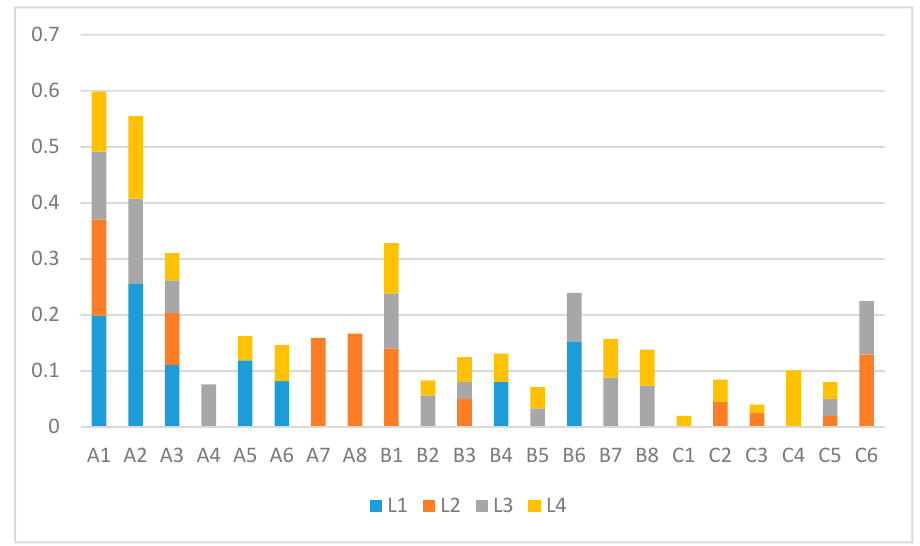
Figure 6. The weight ratio of benefit indices in different stakeholder evaluation.